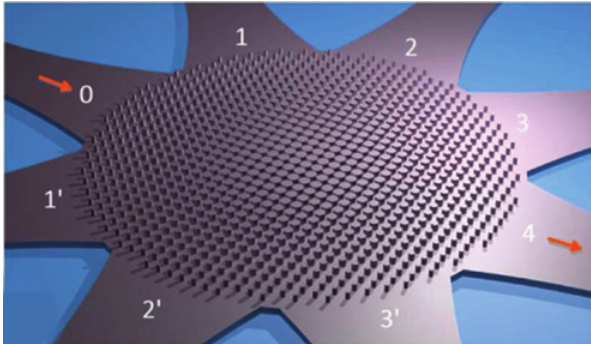
Figure 11: A multiport multimode waveguide crossing using a metamaterial-based Maxwell ’ s fisheye lens [114].